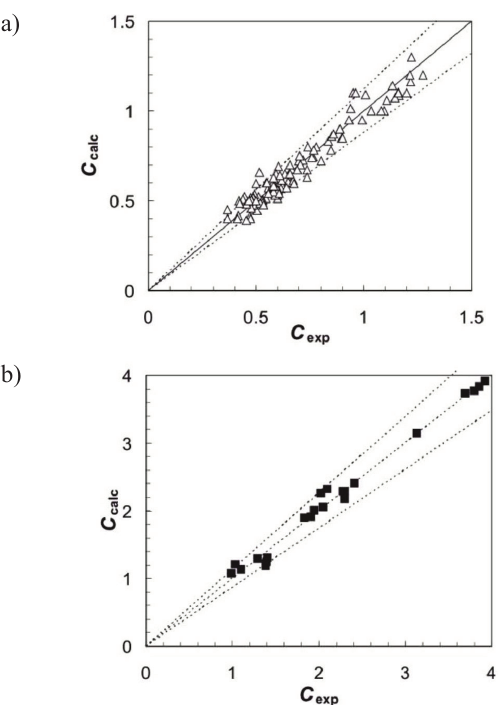
f f values obtained experi­ 1 1 2